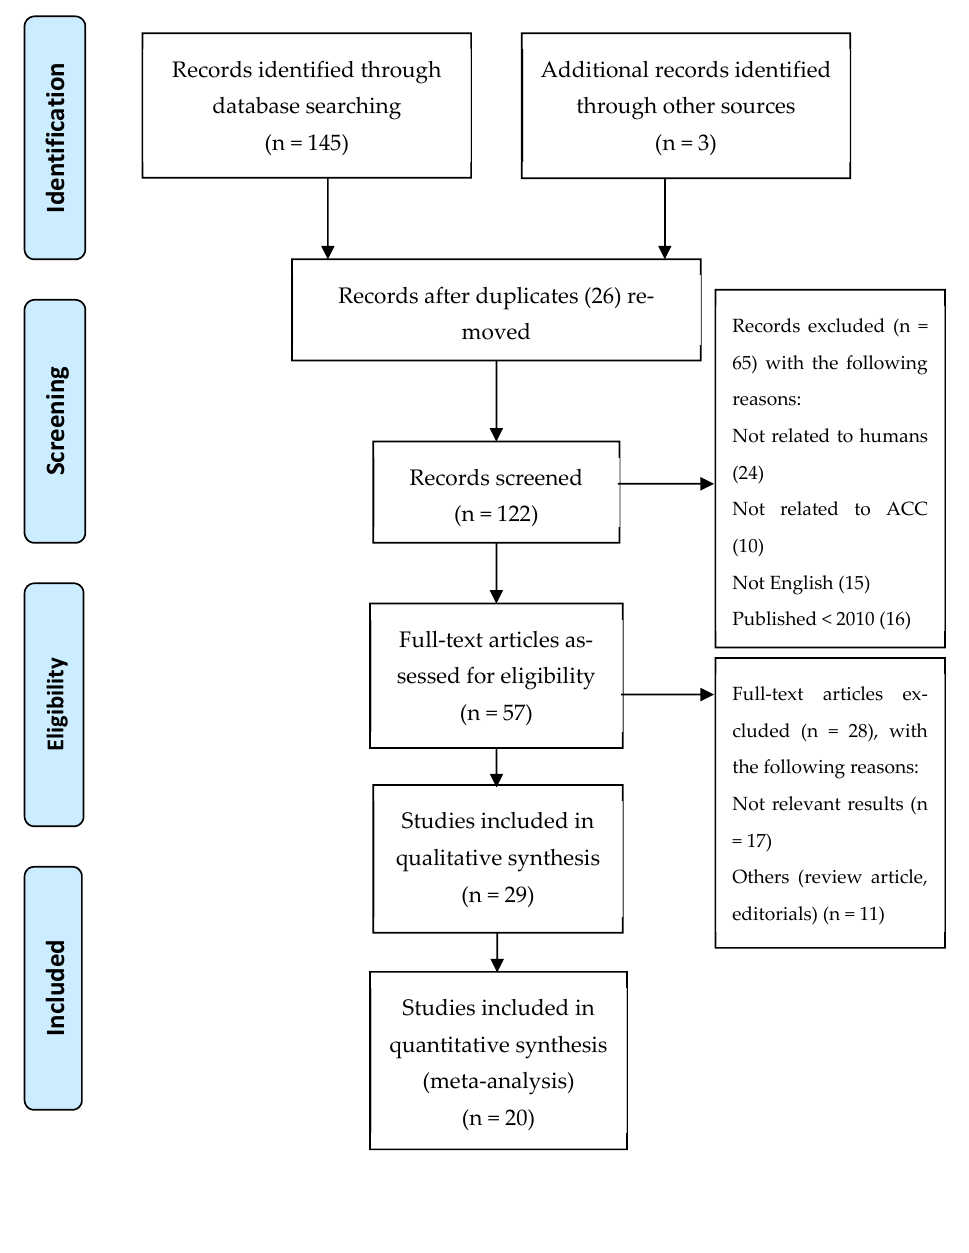
Table 1. Flow diagram of the study selection process.